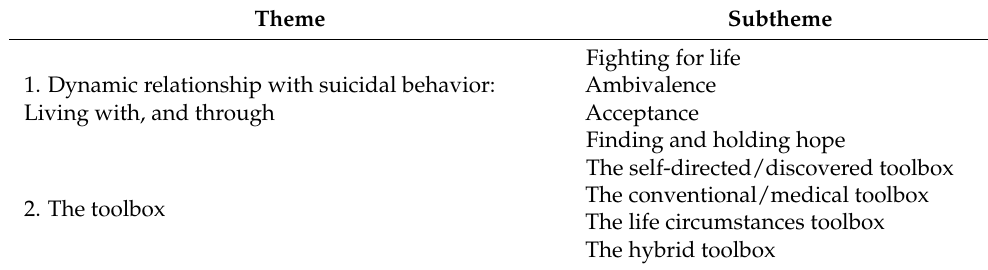
Table 2. Description of themes. Theme